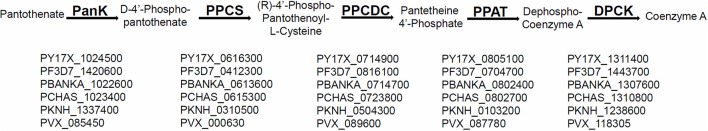
Conservation of CoA biosynthesis pathway in all malaria parasite species. A schematic representation of the canonical biosynthesis pathway of CoA from pantothenate with enzymes PanK (Pantothenate Kinase), PPCS (Phosphopantothenylcysteine Synthase), PPCDC (Phosphopantothenylcysteine Decarboxylase), PPAT (Phosphopantetheine Adenylyltransferase), and DPCK (Dephospho-CoA Kinase), respectively. The PlasmoDB IDs for the genes encoding the biosynthesis enzymes of CoA, that are conserved by homology and synteny in all sequenced malaria parasite species, are listed under each enzyme in P. yoelii, P. falciparum, P. berghei, P. chabaudi, P. knowlesi, and P. vivax, respectively.